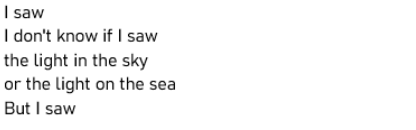
Figure A1. The French BHK text [15] (left panel) used to generate the cross-culturally adapted Por- tuguese version (shown in Figure 2) and the literal translation of the Portuguese version into English (right panel).